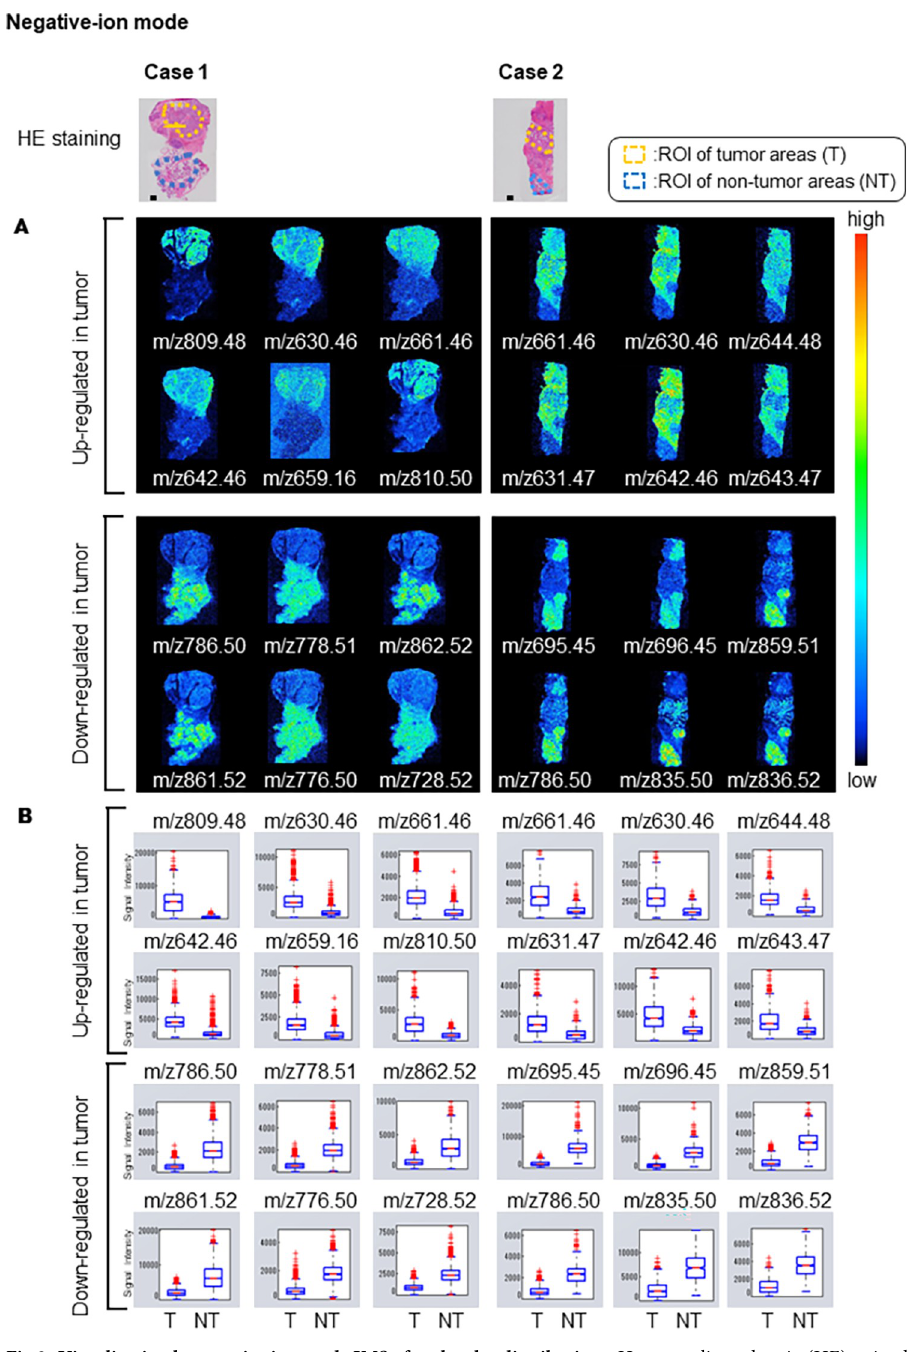
Fig 2. Visualization by negative ion mode IMS of molecular distributions. Hematoxylin and eosin (HE) stained images show defined tumor (T) and non-tumor (NT) areas. A. Representative images of peaks ( m/z ) with significantly different ion intensities in the tumor and non-tumor areas, which are indicated by red and blue circles on the tumor/ non-tumor graph in S3 Fig. The threshold of the color scale was adjusted for each ion image to show a clear distribution. B. Box plots represent the signal intensities of the T and NT regions at each m/z . The significance of the difference between tumor and non-tumor regions was determined using Welch’s t-test. A p-value of less than 0.01, was obtained for all m/z signals compared